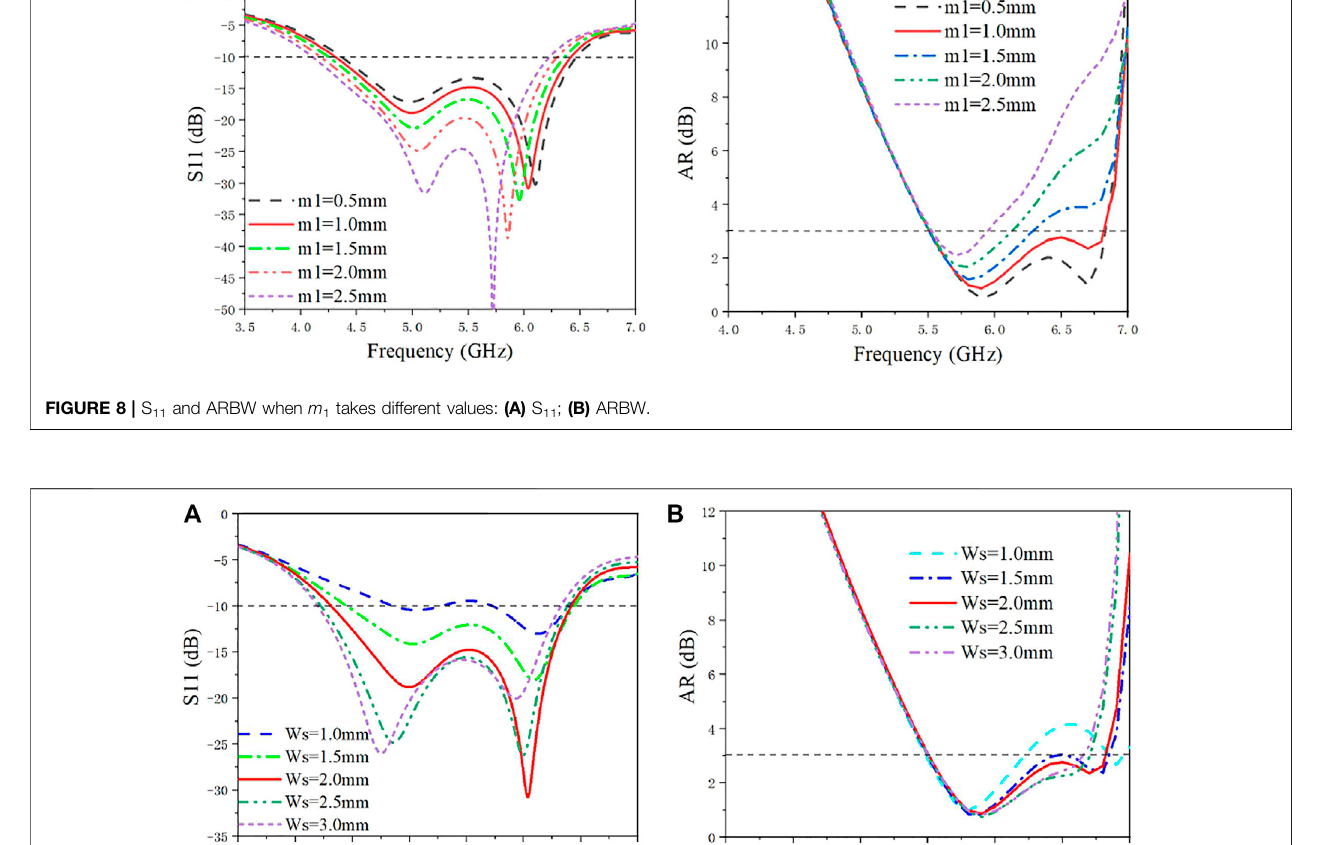
FIGURE 9 | S 11 and ARBW when W s takes different values: